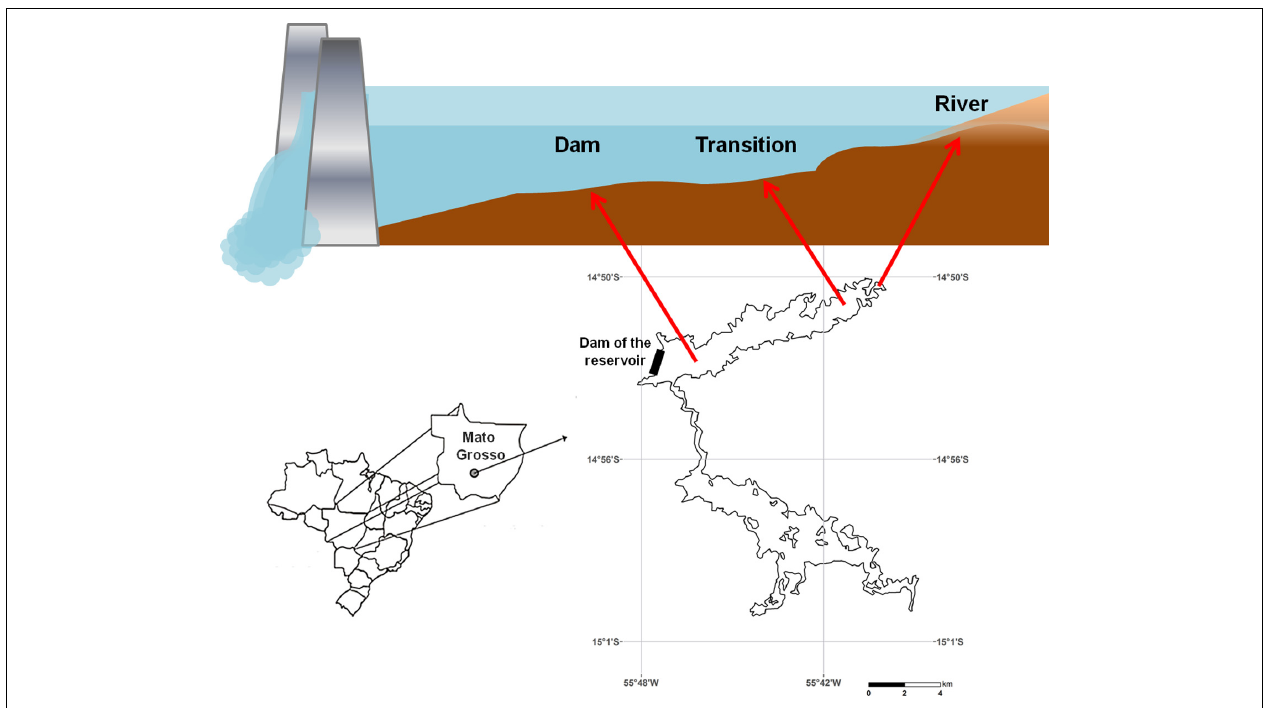
FIGURE 1 | Map of the study area showing the different sampling zones of the Manso reservoir: river (14 m depth) – an area close to the inflow of the Manso River; transition (11 m depth) – an intermediate area between the river inflow and the dam, and dam (27 m depth) – a lacustrine area directly influenced by the dam of the